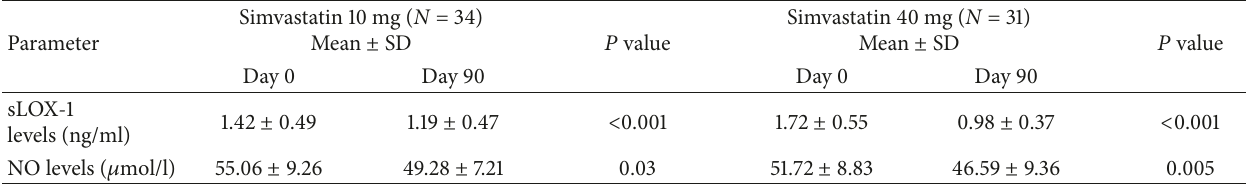
Table 4: Compare serum sLOX-1 and NO levels in patient with acute ischemic stroke at 0 days and 90 days after simvastatin therapy.